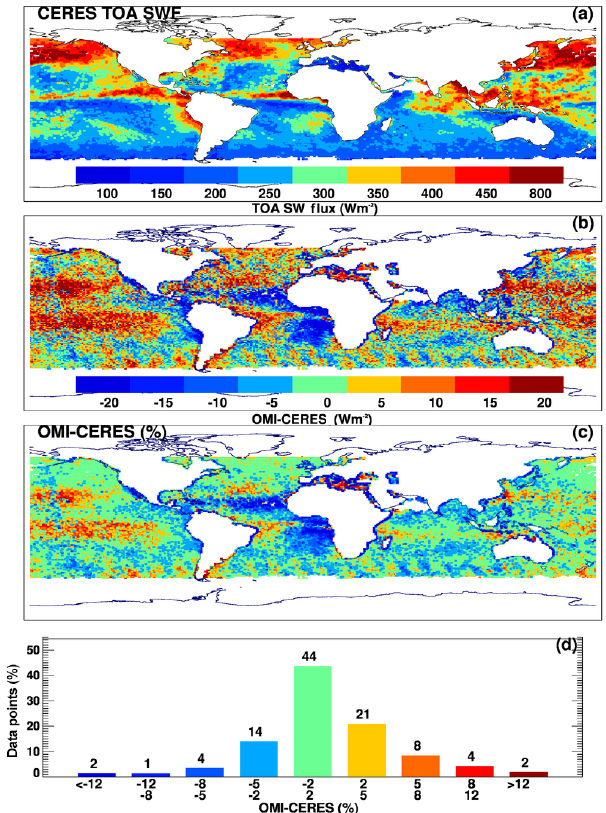
Figure 10. (a) Monthly mean (July 2007) spatial distribution of TOA SW flux from CERES; (b) OMI–CERES (in Wm − 2 ) ; (c) OMI–CERES (percent); (d) histogram of OMI–CERES (per- cent). The colors in (c) correspond to histogram colors in (d) .